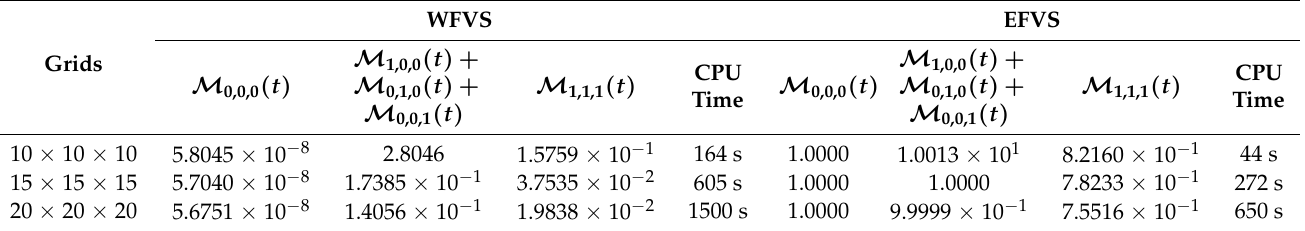
Figure 8. Comparison of zeroth- and first-order moments with selection function S = 1, and breakage functions b 7 . Table 16. Relative error for the weighted moments at different grid points for the test case with S = 1 and breakage functions b 7 at t =